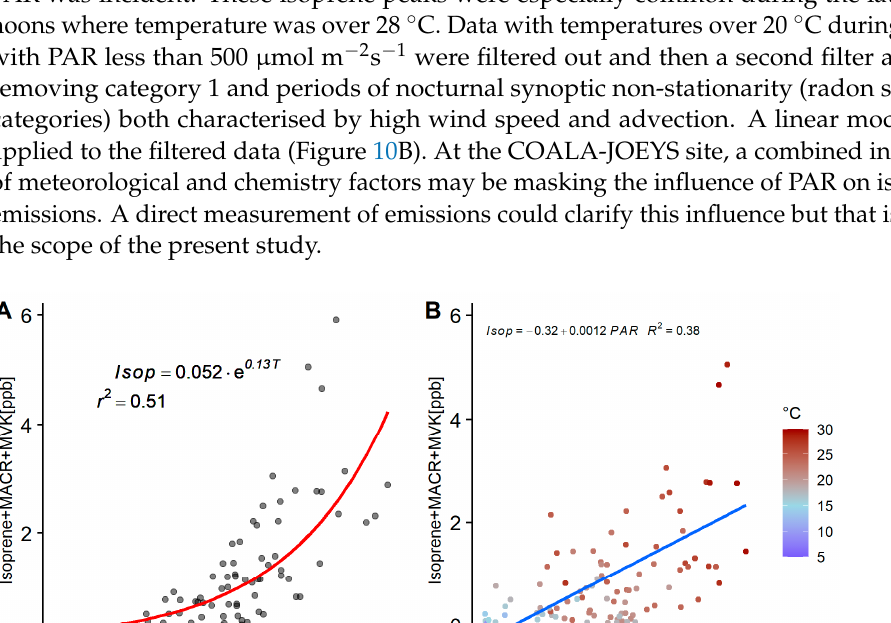
Figure 10. ( A ) Nonlinear fit applied to temperature-isoprene correlation plot. Error values were 0.013 and 0.019 for the exponential factor. ( B ) Correlation plot of PAR against isoprene and its oxidation products, coloured by ambient temperature. Isoprene measurements were filtered to exclude transport events. Only the daylight data were used to estimate the linear fit to reduce the noise from the night data, as well as the data coming from SW-N to capture the highest concentrations of Isop-ox in the